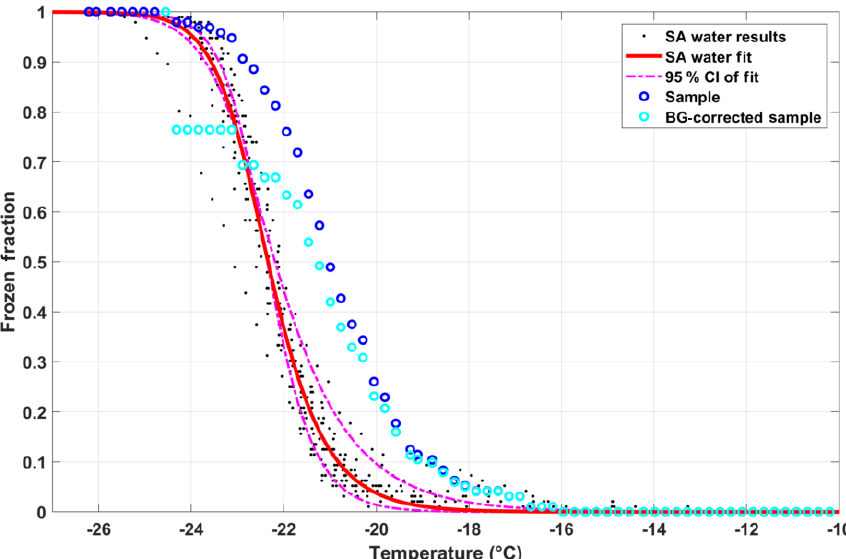
Figure 8. SA water data (black dots) and corresponding fit (red line; Eq. 8), including the 95th-percentile confidence interval (CI; dashed– dotted magenta lines). The blue circles represents the diluted snow sample collected on 30 November 2017, which is then corrected for the contributions of freezing from the SA water using the background correction (FF cor (T ) as described in Eq. 11; cyan